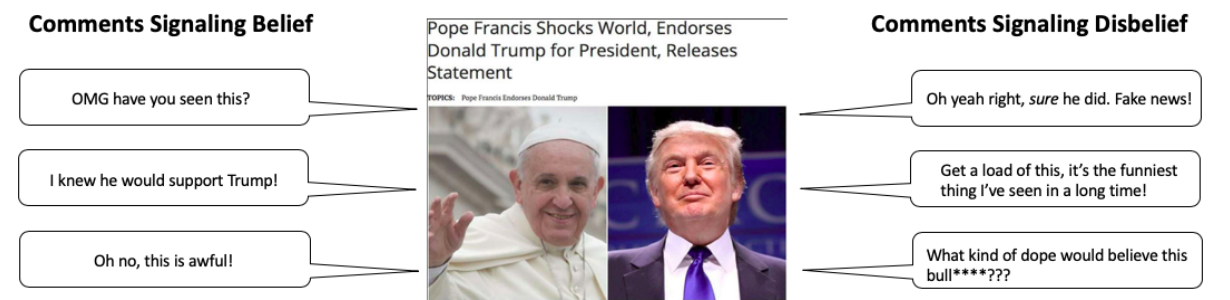
Figure 1. Example of a fake news post with examples of hypothetical commentary that signal a range of beliefs by the sharer. Source: “Pope Francis shocks world”